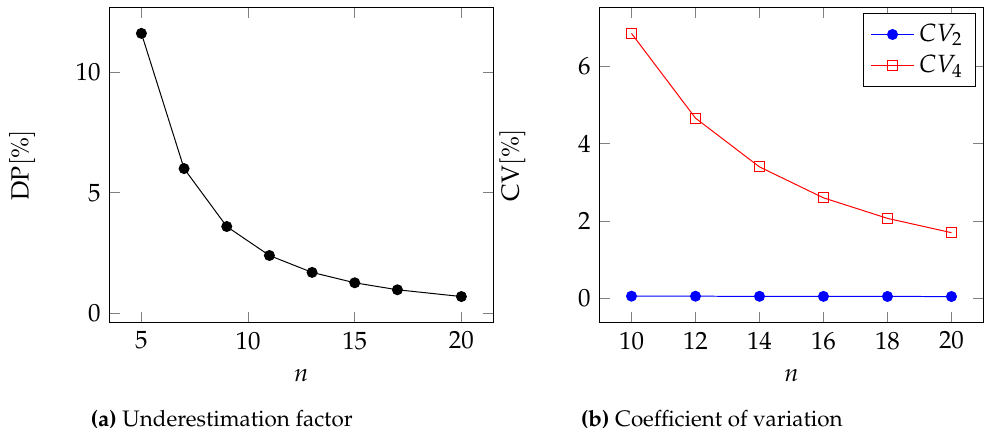
Figure 4. Performance metrics for the Gamma case (distribution parameters as in Table